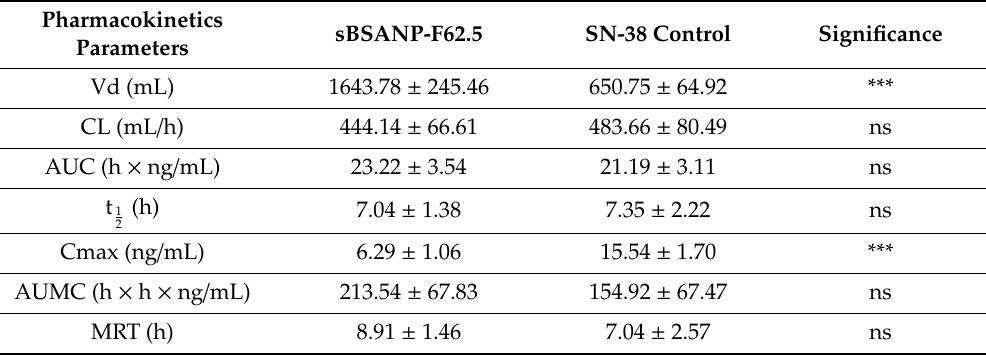
Figure 10. In vivo plasma concentration of SN-38 versus the time profiles of the SN-38 control group and sBSANP F-62.5 at 315 µg/mL in male Sprague Dawley rats after intravenous infusion (0.1 mL/min) administration (n = 4). Note: The SN-38 control group solution was composed of 10% DMSO, 20% Cremophor EL, and 70% PBS (pH 7.4). Table 3. Comparison of the pharmacokinetic parameters of the SN-38 control and SN-38-loaded sBSANP-F62.5 mg/mL at 315 µg/mL dosage after intravenous infusion administration to male Sprague Dawley rats.